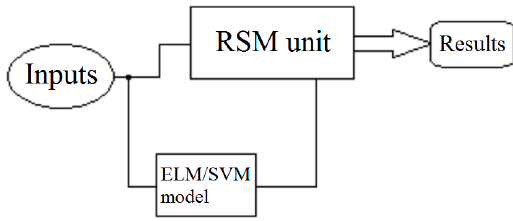
Figure 4. Schematic diagram of the developed hybrid method.